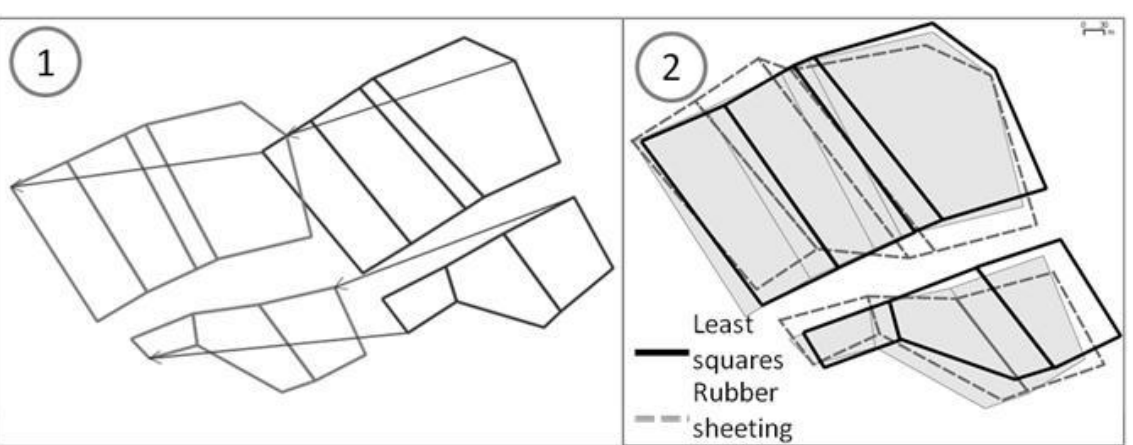
Figure 23. ( 1 ) Conflation benchmark data ( 2 ) least squares and rubber sheeting results compared to benchmark final data.